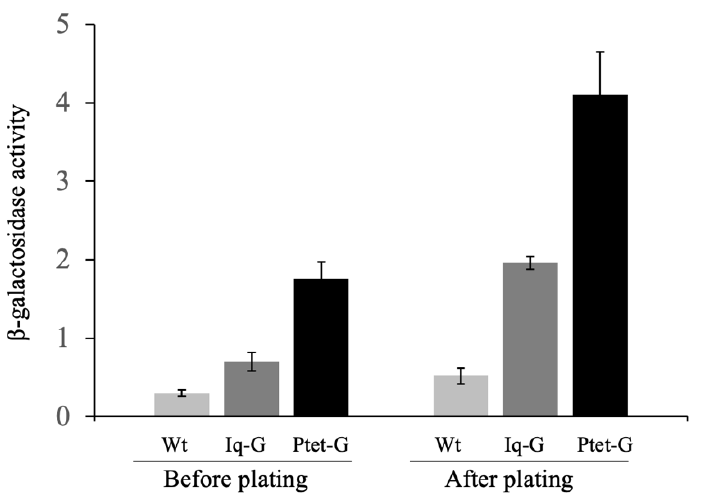
Figure 7. Effects of BglG levels on residual bgl operon transcriptional activities in cells before plating and after plating onto M9 + salicin agar plates. The wild-type, Iq-G and Ptet-G cells (all carrying the operon lacZ reporter, P bgl - bglG - lacZ , chromosomally integrated at the lacZ site) were cultured in LB for 8 h, washed 2x with M9 salts and diluted to OD 600 of 0.1 before plating. The operon activities before plating, as indicated by β-galactosidase activities, were measured, based on the operon lacZ reporter. An amount of 200 μL of the cell suspensions were applied onto M9 + salicin agar plates that were incubated at 30 °C. After 1.5 days of incubation, the cells were washed off the plates using an M9 salts solution, and the cell suspensions were assayed for β-galactosidase activities (i.e., operon activity after plating) (see Methods). β-galactosidase activities were measured following expression of bglG under the control of the native bgl operon promoter, or after overexpression of bglG using either the lacIq promoter or the stronger P tet promoter. Measurements were made either before plating (left) or after plating (right) as indicated.